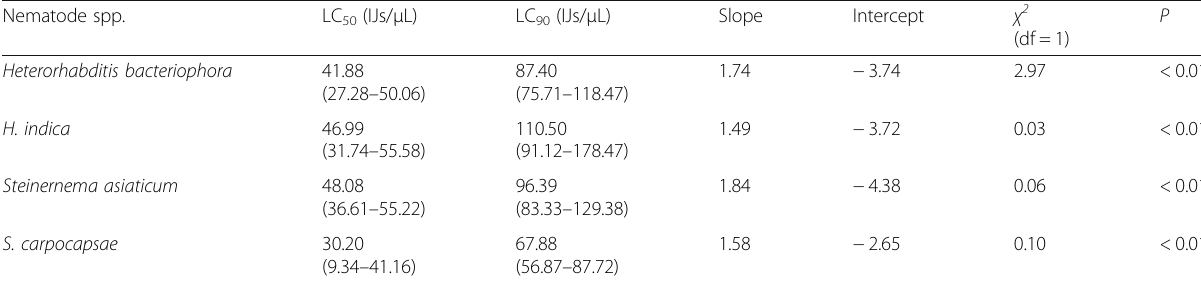
Table 2 Lethal concentrations (LC 50 and LC 90 ) of the tested EPNs against Bactrocera dorsalis maggots Nematode spp.